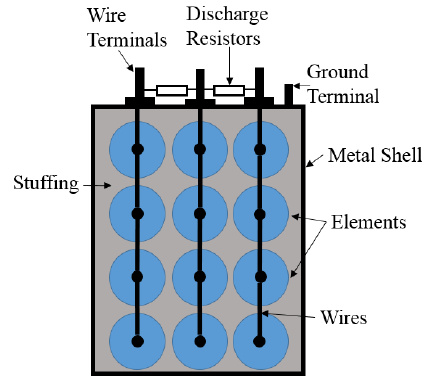
Figure 1. Structure of a typical metallized film capacitor (MFC).